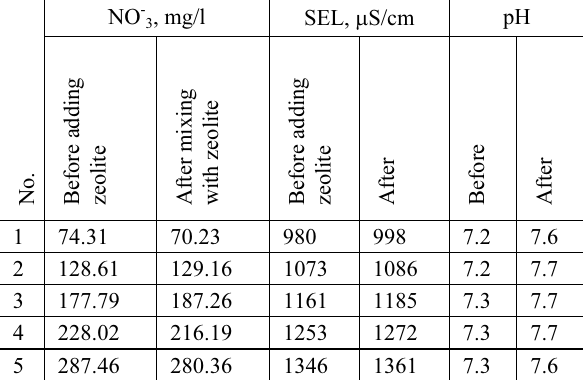
Table 2. Adsorption measurement